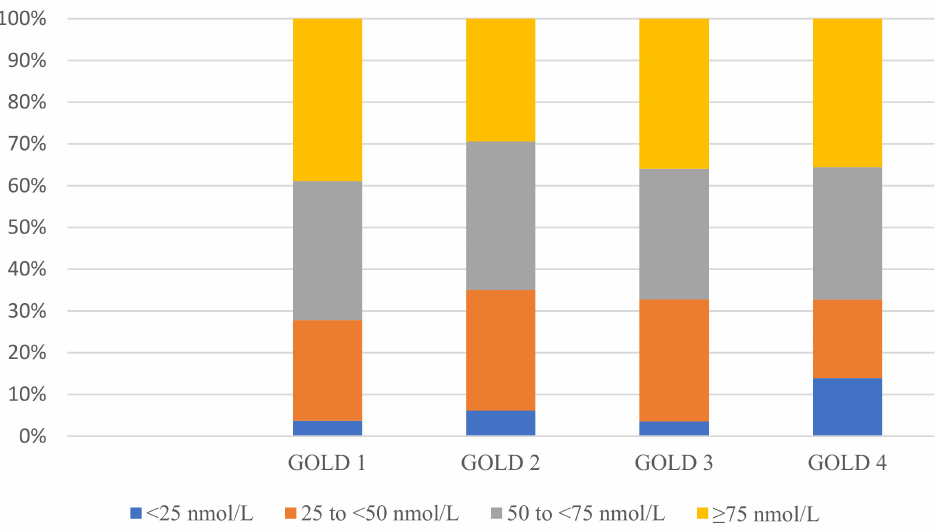
Figure 3. Vitamin D status (25-Hydroxyvitamin D, nmol/L) stratified by GOLD grade. Numbers within GOLD grade: GOLD grade 1 n = 54, GOLD grade 2, n = 228, GOLD grade 3 n = 284 and GOLD grade 4 n = 101. Abbreviations: GOLD, Global Initiative for Chronic Obstructive Lung Disease. Fisher-Freeman-Halton Exact test p = 0.031 (significant p -value < 0.05). Table 2. Result from the multivariable logistic regression analysis, showing determinants of vitamin D insufficiency among patients with COPD.